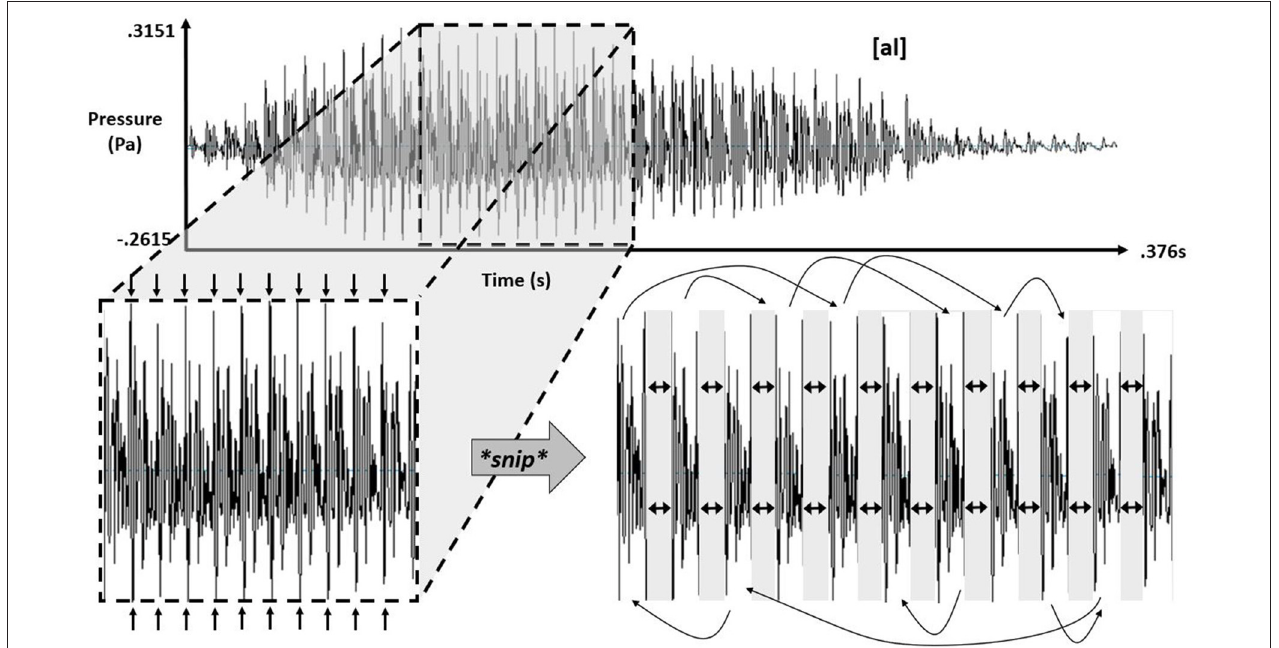
FIGURE 3 | Schematic showing the process of isolating 11 pitch periods within the vowel component of “[al]” and subsequent separation for later randomization, with eight different randomizations each producing a new variant of simulated speech [al].